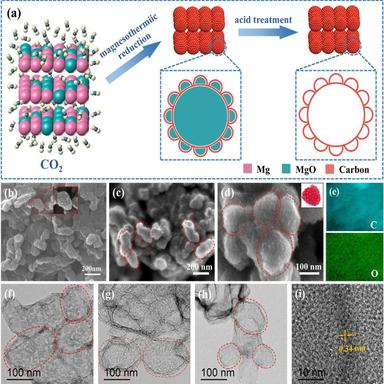
Preparation and morphology of raspberry-like carbon superstructures (RCSSs). (a) Schematic illustration for the preparation of RCSSs. (b–d) SEM image of RCSSs at different magnifications. Red dashed circle indicates the single particle. It could be found that RCSSs were 100–200 nm particles with rough surfaces constructed by great number of uniformly distributed microparticles, which enabled RCSSs to exhibit a raspberry-like morphology. Every single RCSS particle contacted to each other and consequently for